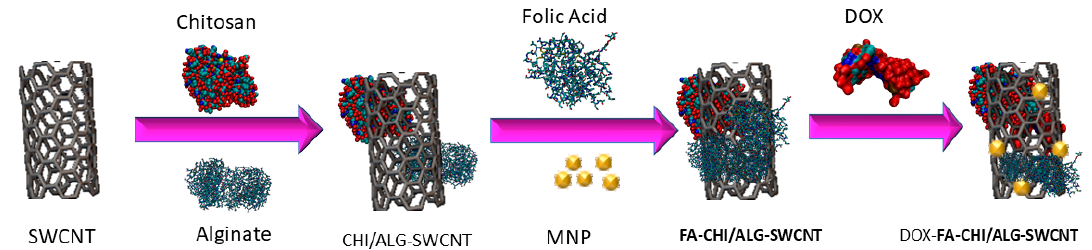
Figure 3. The process of conjugating a carbon nanotube with chemical compounds. Single-wall carbon nanotube (SWCNT) conjugated with sodium alginate (ALG), chitosan (CHI), folic acid, and doxorubicin hydrochloride.